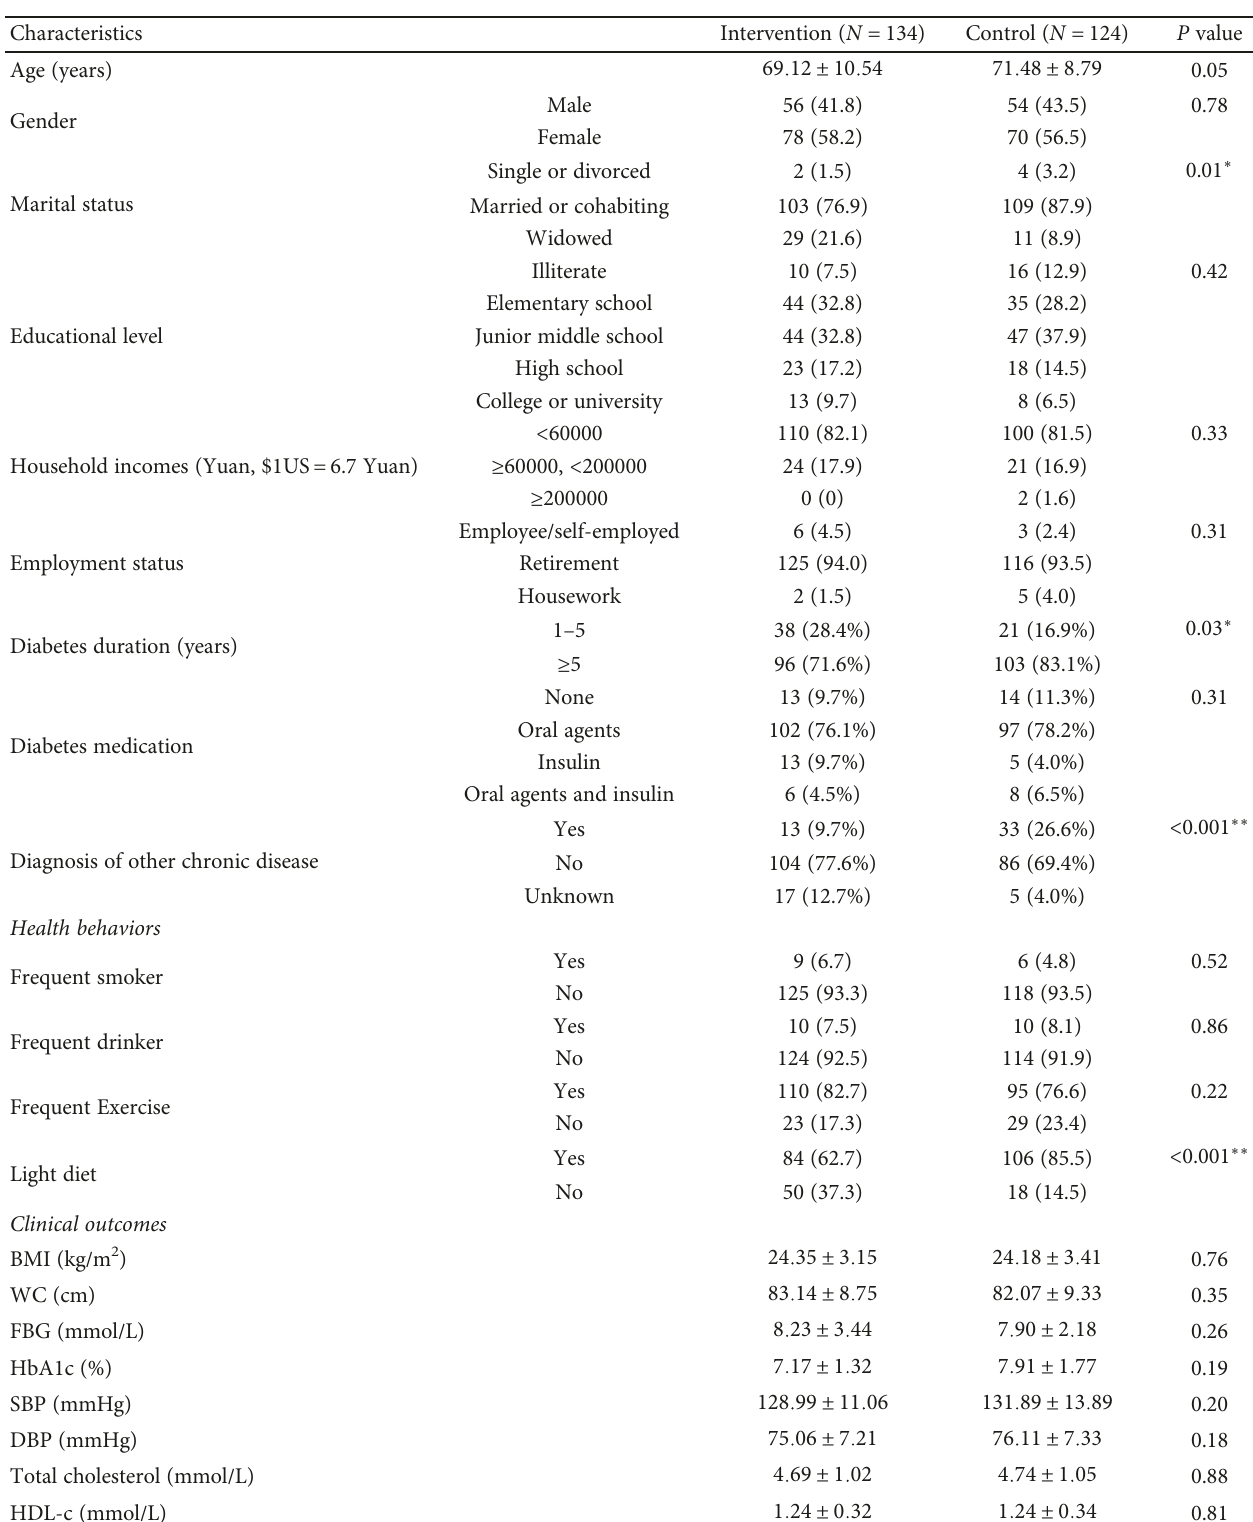
Table 1: Characteristics of the study participants at the baseline in a 9-month group randomized experimental study in China, 2009-2010.